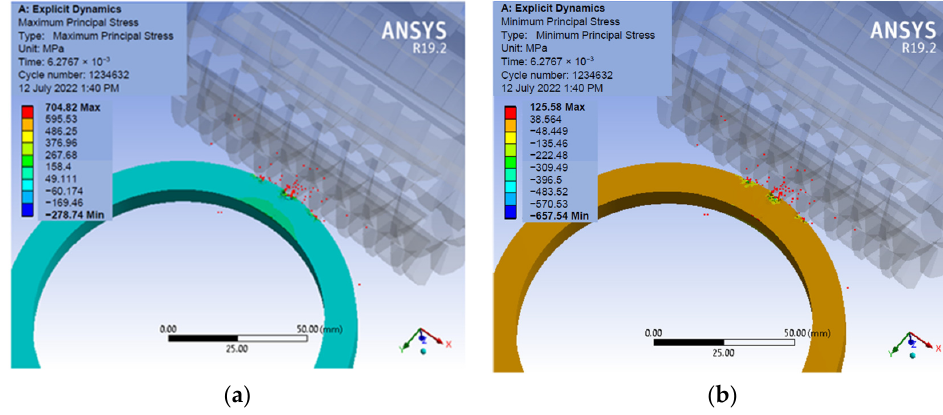
Figure 9. Computed ANSYS principal stress map: ( a ) maximum; ( b ) minimum.